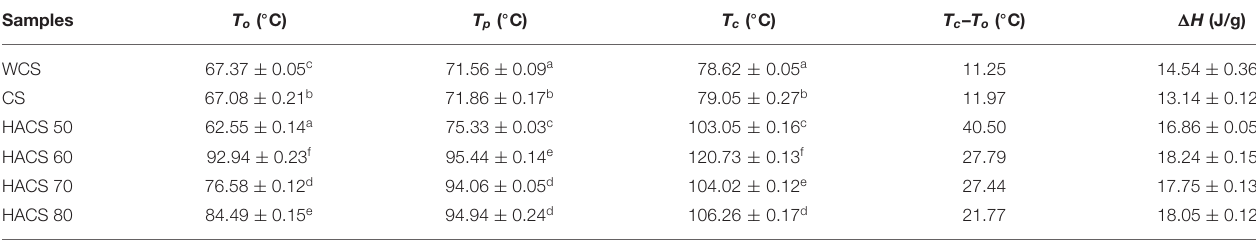
TABLE 3 | Thermodynamic parameters of corn starch with different amylose content. Samples